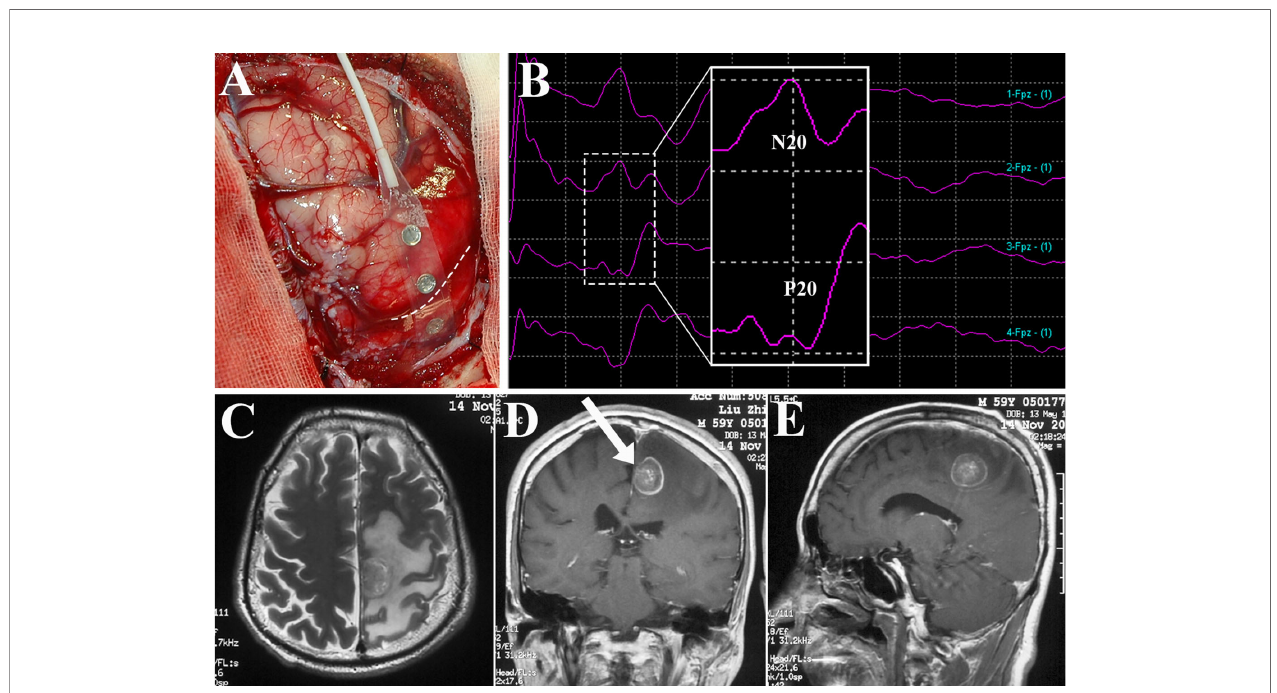
FIGURE 3 | Identi fi cation of the central sulcus and sensorimotor cortex using brain mapping. Subdural electrode strip was placed over the perirolandic region (A) to record SEPs, and N20-P20 phase reversal (B) gave information about the site of the central sulcus (dotted line in A). After direct motor cortex mapping, BM allocated within the left paracentral lobule as depicted in axial T2-weighted MRI (C) and contrast sequence in the coronal (D) and sagittal planes (E) was removed via the contralateral transfalcine approach (arrow in D ). SEPs, somatosensory evoked potentials; MRI, magnetic resonance